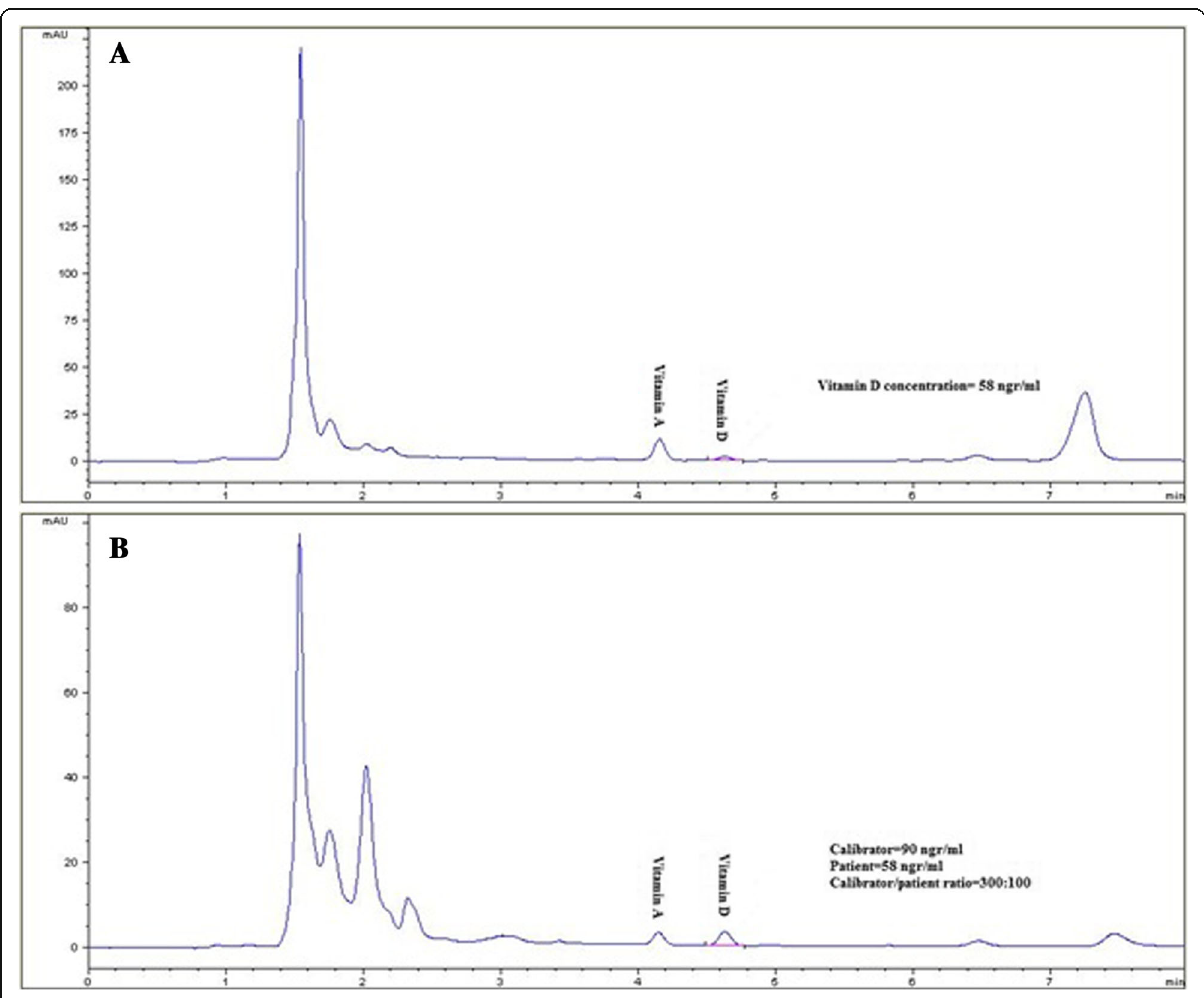
Fig. 2 HPLC chromatograms of a serum sample before ( a ) and after ( b )